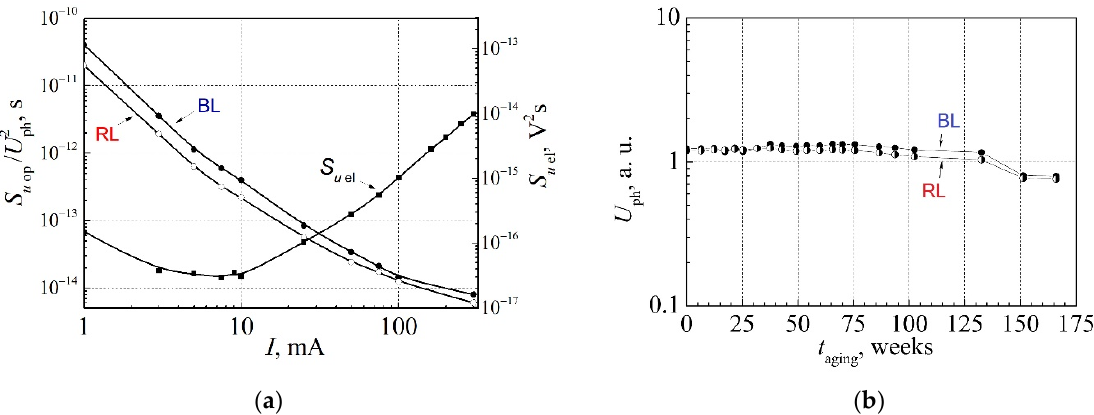
Figure 14. ( a ) Dependences of the electrical (right scale) and relative optical (left scale) noise spectral density on forward current at low 22 Hz frequency before aging of the high-power white LED measured by the BL photodetector (solid dots) and by the RL photodetector (open dots); ( b ) change of the light intensity measured by the BL photodetector (solid dots) and by the RL photodetector (half-filled dots) at forward 100 mA current during the long-term aging.